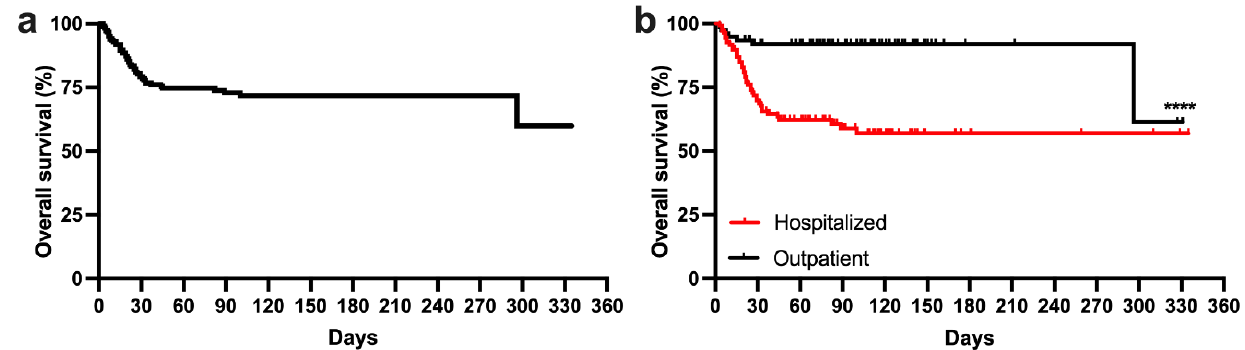
Figure 1. Kaplan – Meier survival curves of the whole ( a ) and hospitalized ( b ) patient cohorts. **** p < 0.0001 (Log-rank test).